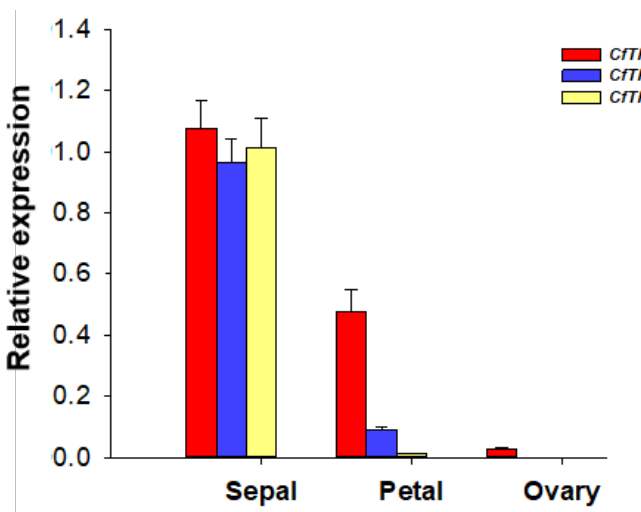
Figure 7. Expression patterns of CfTPS1-3 in three different organs of C. florida ‘Kaiser’ by real-time PCR. Data were presented as means of three biological replicates with error bars indicating standard deviations.